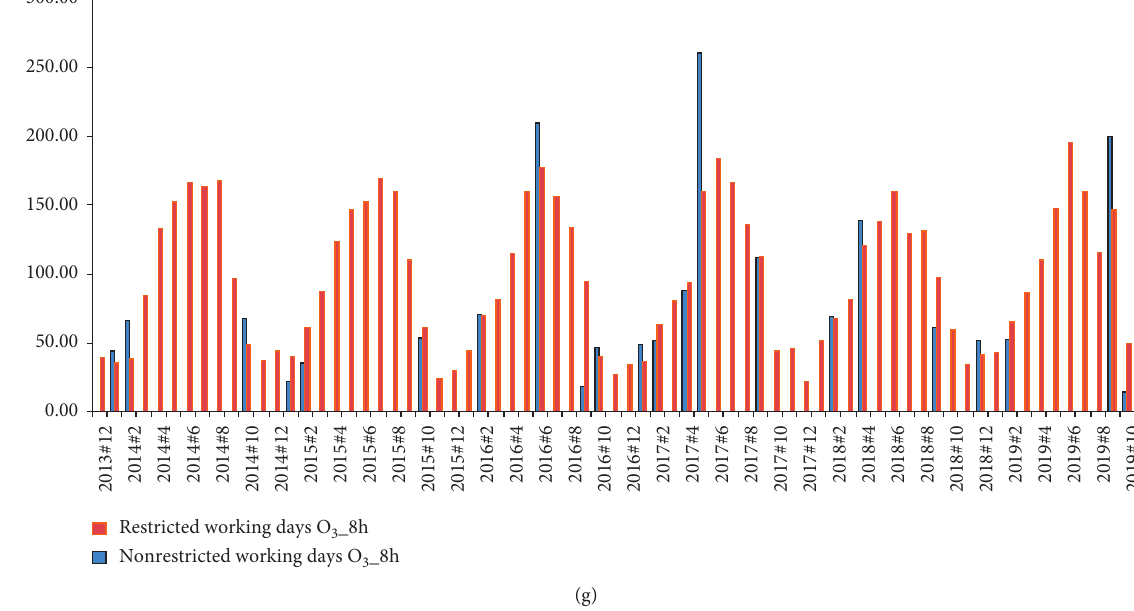
Figure 3: Comparison of restricted working days and nonrestricted working